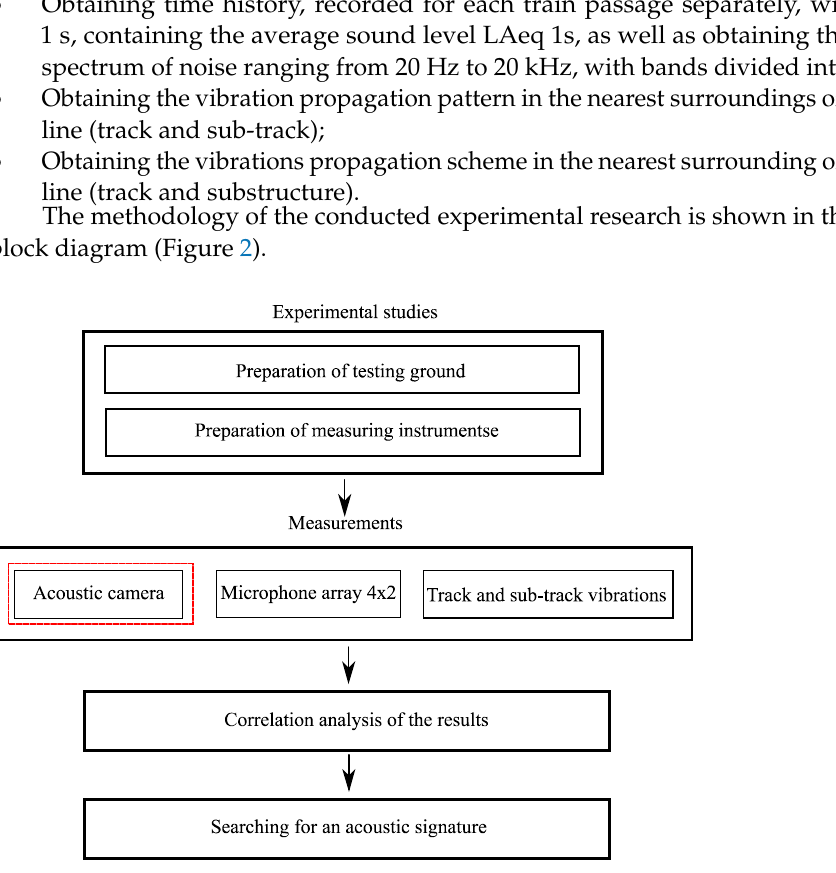
Figure 2. The Block diagram of the methodology of the conducted experimental research.